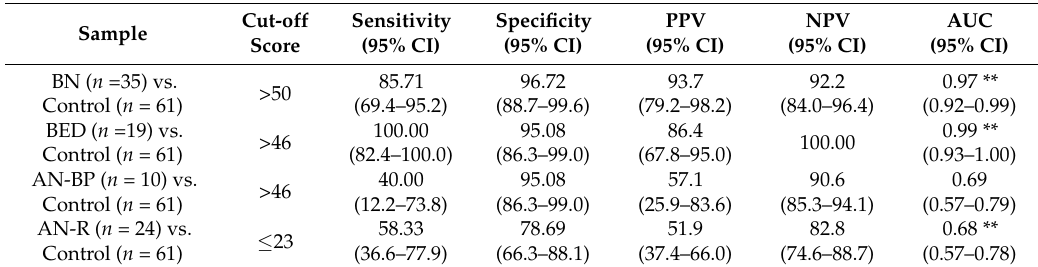
Table 8. Results from receiver operating characteristics (ROC) Curve Analyses for EBQ-18 total score across different diagnostic